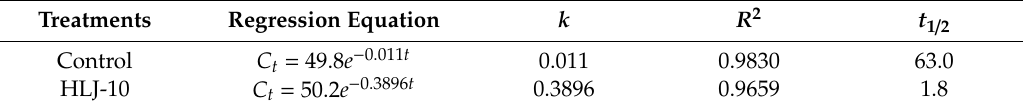
Table 2. Kinetic parameters of D-cyphenothrin degradation with Staphylococcus succinus HLJ-10 in mineral salt medium (MSM).